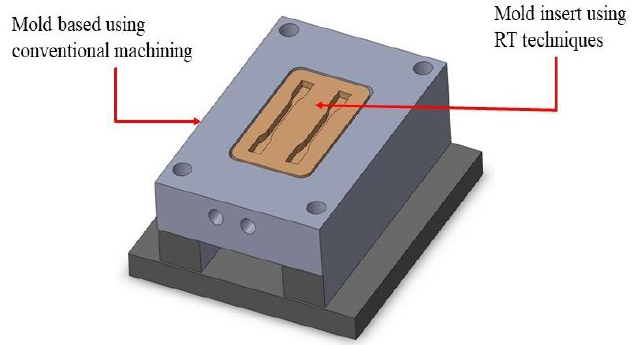
Figure 1. The hybrid-mold concept.